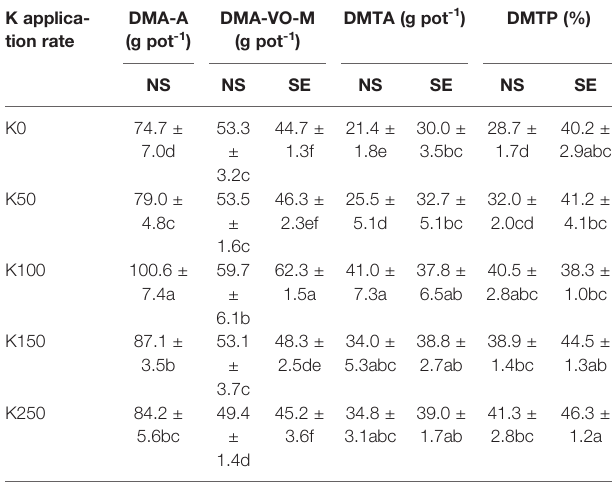
TABLE 3 | Effect of potassium rate and shading-stress on plant dry matter accumulation and translocation in wheat. K applica- tion